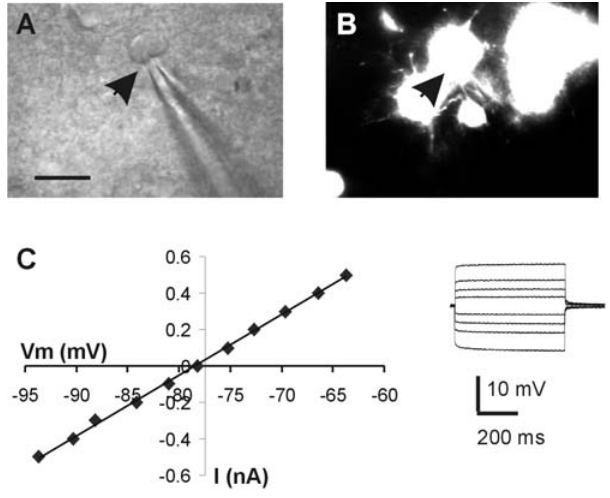
Figure 3. Electrophysiological properties of diffusely fluorescent cells in mutant slices are characteristic of astroglia. (A) IR/DIC image from a mutant slice displays the recording pipette and the cell’s soma. The arrowhead points to the location of the pipette tip. Scale bar=20 m m. (B) A fluorescent image of the same region as in (A) reveals several diffusely fluorescent cells. The arrowhead position is the same as in (A). (C) A series of current pulses at 0.1 nA increments were delivered through the recording pipette (inset). A plot of the current pulse intensity (I) vs. the voltage deflection (Vm) reveals linear relationship characteristic of astroglia.